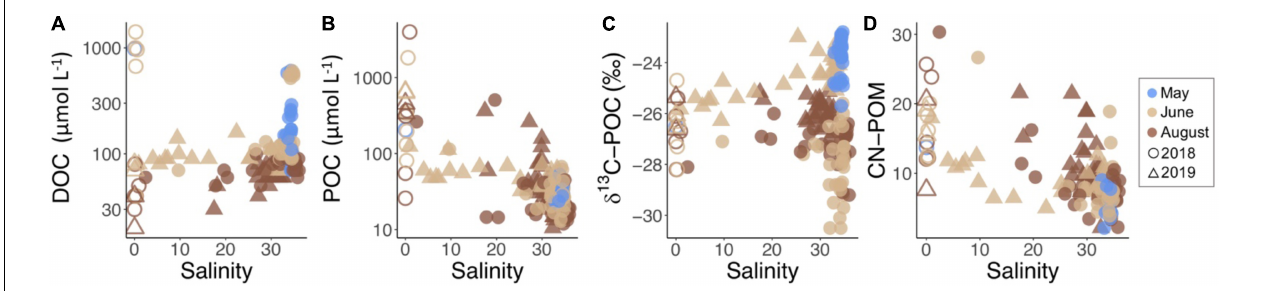
FIGURE 4 | Concentrations of (A) DOC, (B) POC, and (C) δ 13 C-POC and (D) CN ratio of POM vs. salinity for each water sample by year (symbol) and month (color). River samples are further distinguished by open symbols.